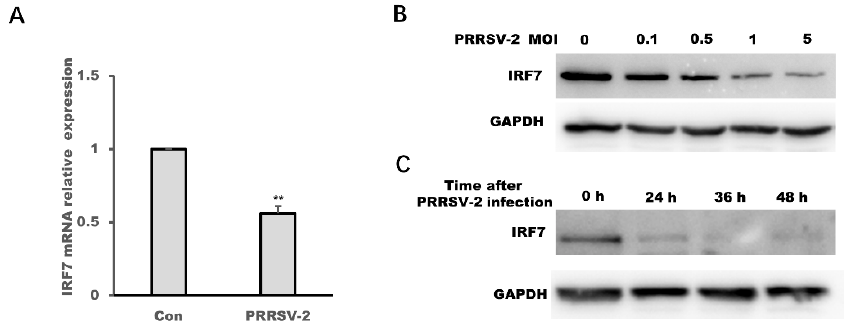
Figure 5. PRRSV-2 infection down-regulated the expression of interferon regulatory factor 7 (IRF7). ( A ) MARC-145 cells were infected with PRRSV-2 at a multiplicity of infection (MOI) of 0.1, and 36 h later, the mRNA expression levels of IRF7 were assessed by quantitative real time polymerase chain reaction (qRT-PCR). ( B ) MARC-145 cells were infected with PRRSV-2 at different MOI, and 24 h later, the protein expression levels of IRF7 were assessed by Western blots. ( C ) MARC-145 cells were infected with PRRSV-2 at an MOI of 0.1, and 24 h, 36 h or 48 h later, the protein expression levels of IRF7 were assessed by Western blots. All experiments were repeated at least three times with similar results. * p < 0.05; ** p < 0.01.